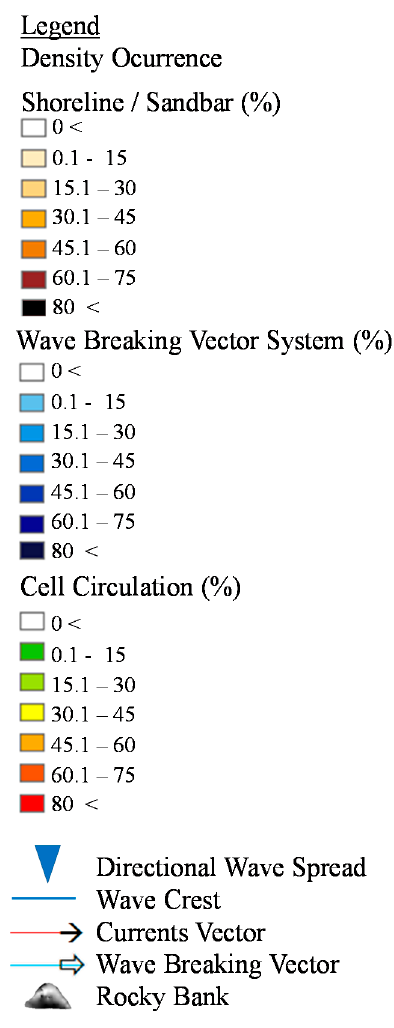
Figure 10. The wave breaking vector system on the Reserva rocky bank geometry combined with the hydrodynamic (cell circulation) and shoreline responses. Results ( a ) and ( b ) represent the depositional and erosive groups, which are governed by moderate and low-energy waves, respectively. Result ( c ) represents the dissipative group governed by high-energy waves. Shoreline changes, wave breaking vectors, and cell currents are represented by percentage of density occurrence (considering the cases in Figures 5–7).